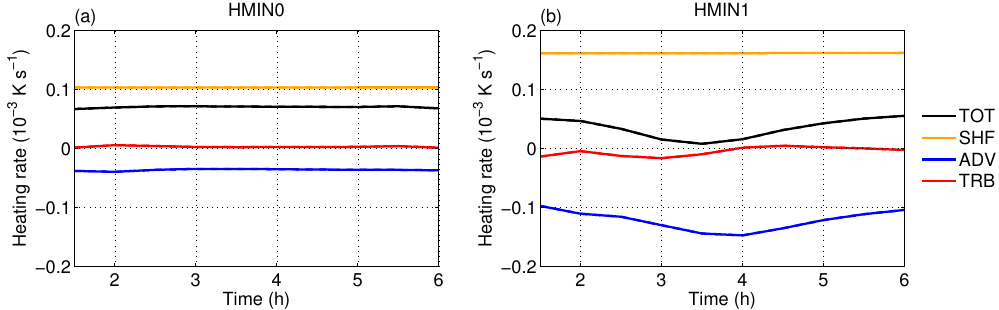
Figure 7. Evolution of density-weighted and volume-averaged heat budget components for (a) the HMIN0 and (b) the HMIN1 simulation. The total tendency (TOT) is equal to the sum of surface sensible heat flux (SHF), mean flow advection (ADV), and turbulent exchange (TRB). Both control volumes extend from the first to the main ridge and from the surface to an altitude of 2 . 1km. Due to technical reasons (time averaging), values are only shown after 1 . 5h of